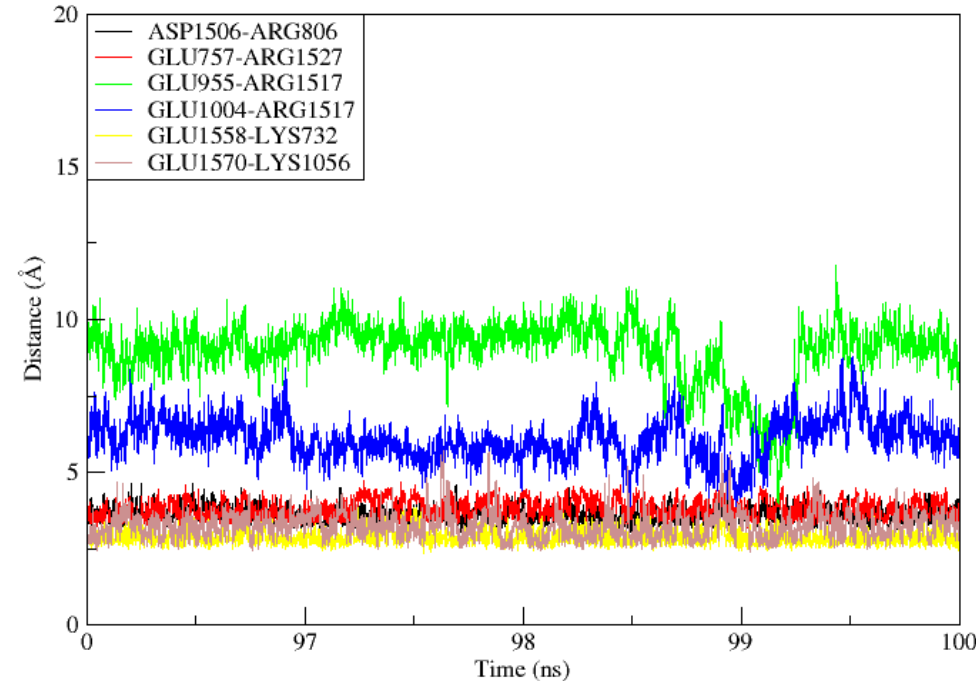
Figure 9. During the 100ns simulation period, salt bridges developed between TLR4 and Vaccine